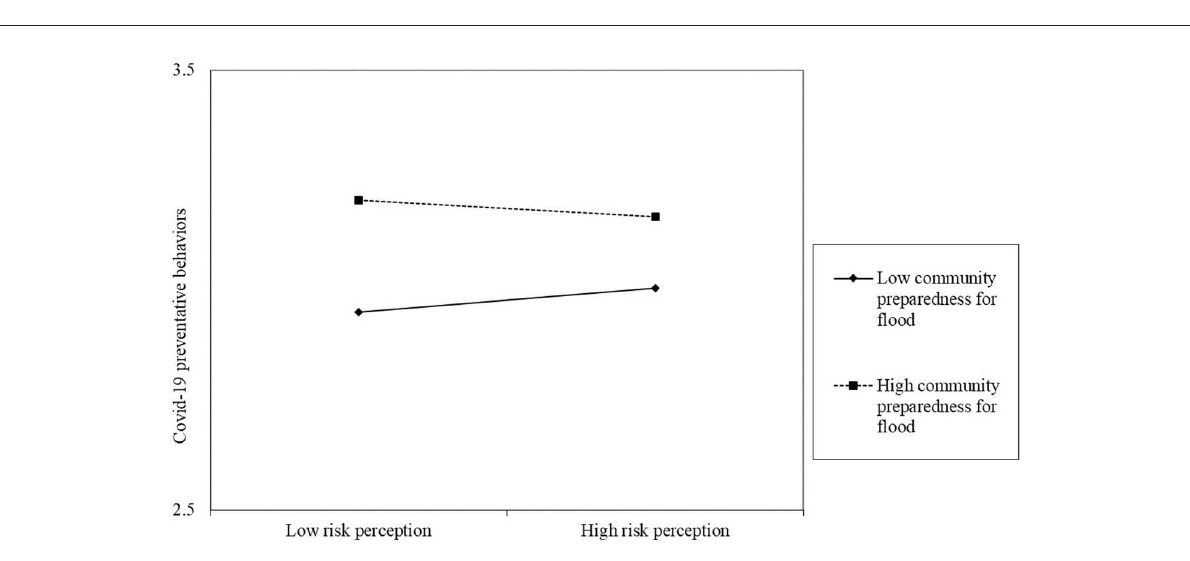
FIGURE2 The moderating effects of community preparedness for flood risk on the relationship between flood risk perception and COVID-19 preventive